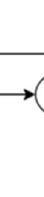
Figure 2. Unfolded RNN.